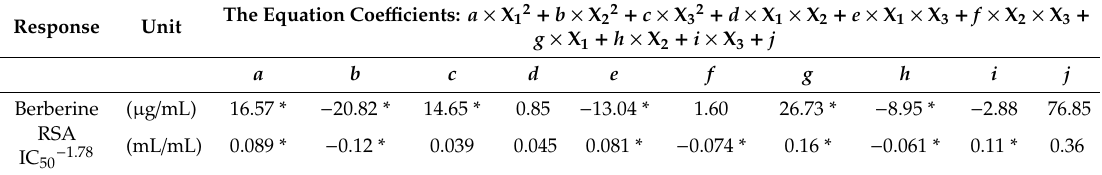
Table 3. Polynomial equations of the models in terms of coded